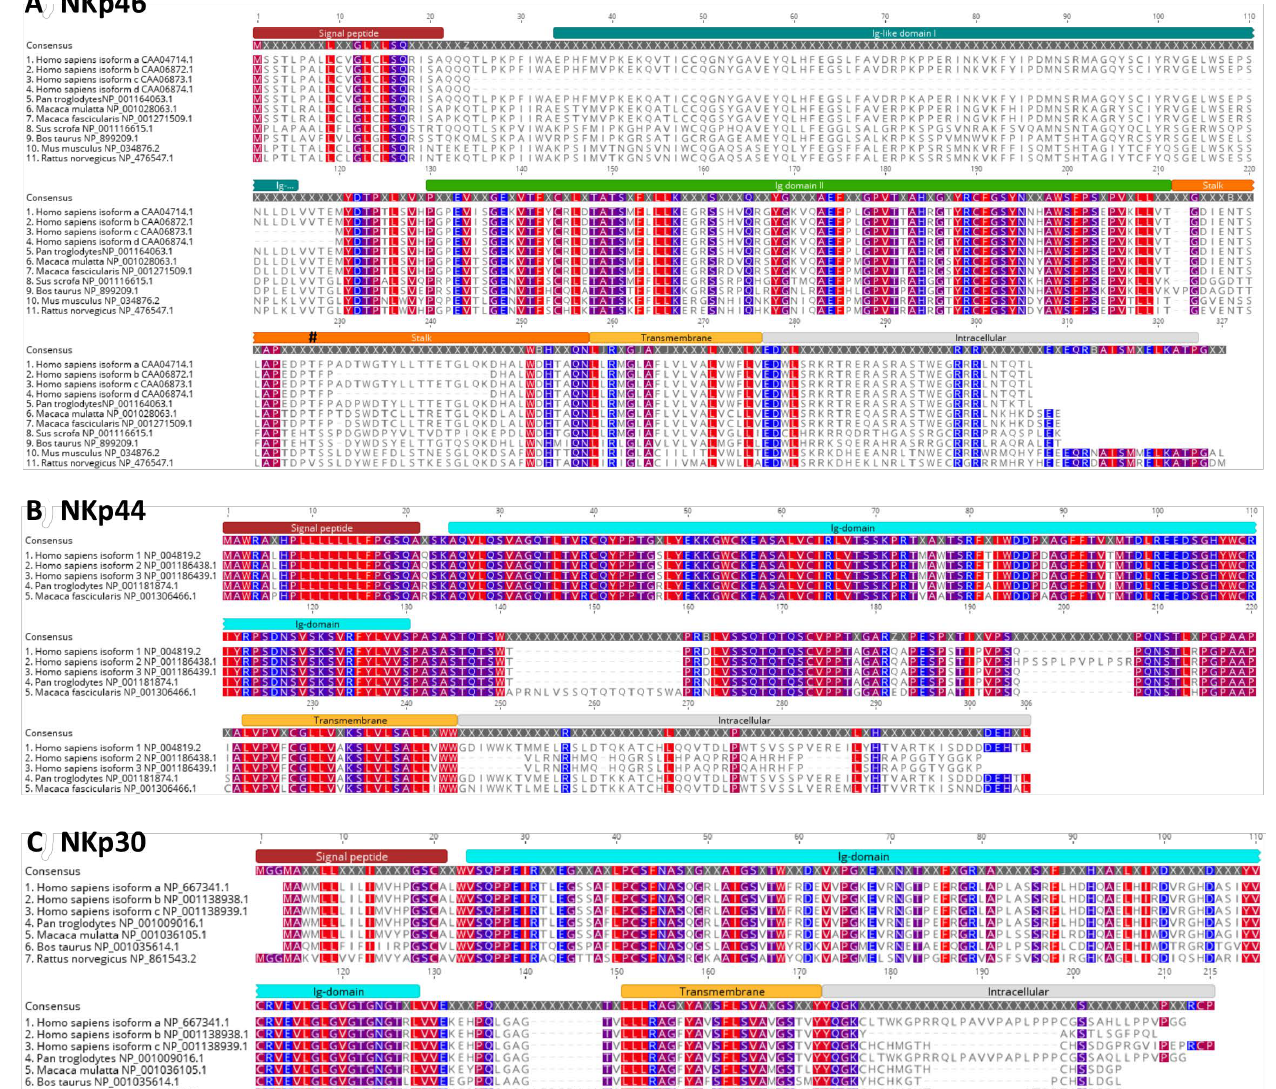
Figure 4. Amino acid sequence alignment of natural cytotoxicity receptor homologs from various species. ( A ) NKp46, ( B ) NKp44, and ( C ) NKp30. Protein domains are indicated above consensus sequence. Sequence alignments were performed using MUSCLE. Conserved amino acids are highlighted. Protein domain predictions were performed using SMART protein domain annotation resource [100]. Predicted O -linked glycosylation site (Thr225) identified to be crucial to HA and hNKp46-Ig interactions indicated by hash sign. NCBI protein accession numbers are